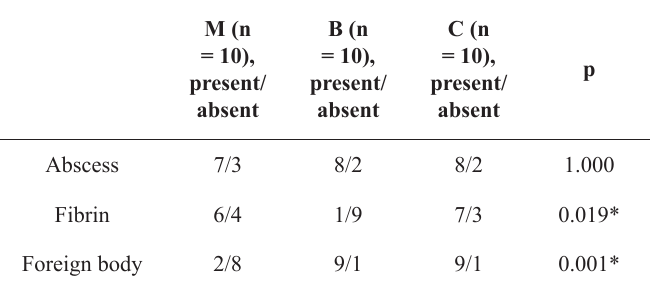
TABLE 3 - Histopathological analysis of animals killed seven days after surgery, in groups M (metoclopramide), B (bromopride) and C (control).